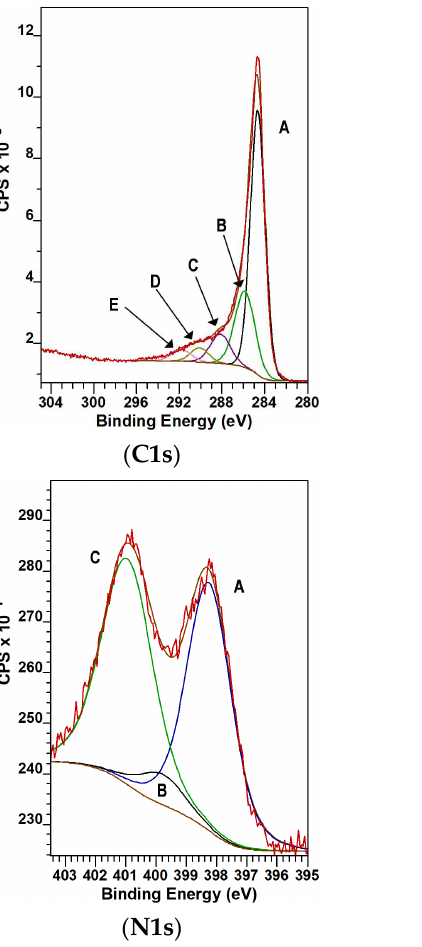
Figure 4. Deconvoluted C1s, O1s, N1s and S2s regions of the CA sample. The total O + N + S heteroatom/carbon ratio on the surface of the purified sample is close to 11%, with practically an equal share of the O and N species. The species revealed by the deconvolution of the C1s, O1s, N1s and S2p regions were assigned according to Table S2. Based on the C1s and O1s regions, the surface of the CA carbon is decorated with carbonyl, epoxy, and carboxylic groups. Nitrogen in three different forms, namely in pyridinic, pyrrolic and quaternary, was detected. The S2p peak is split into 2p3/2 and 2p1/2 with 2:1 intensity and a 1.2 eV binding energy gap. The double peak at around 163.8 eV, 165 eV shows the exclusive presence of thiophenic compounds in the final product. Table 2. Surface compositions (atomic %) measured by XPS.